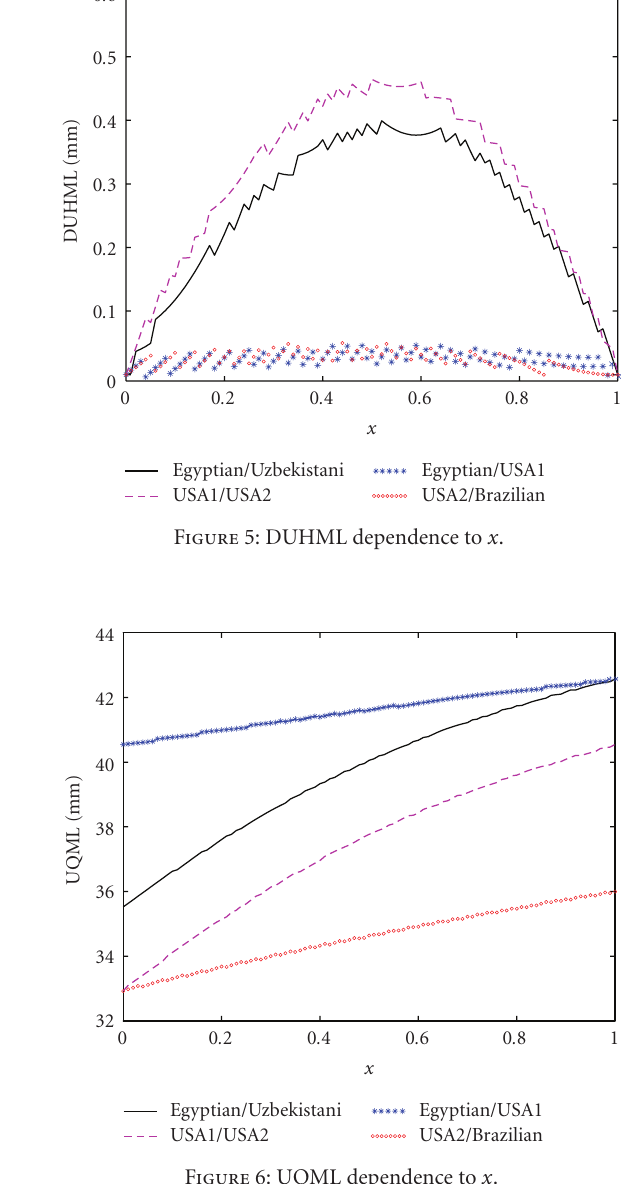
Figure 4: UHML dependence to x .